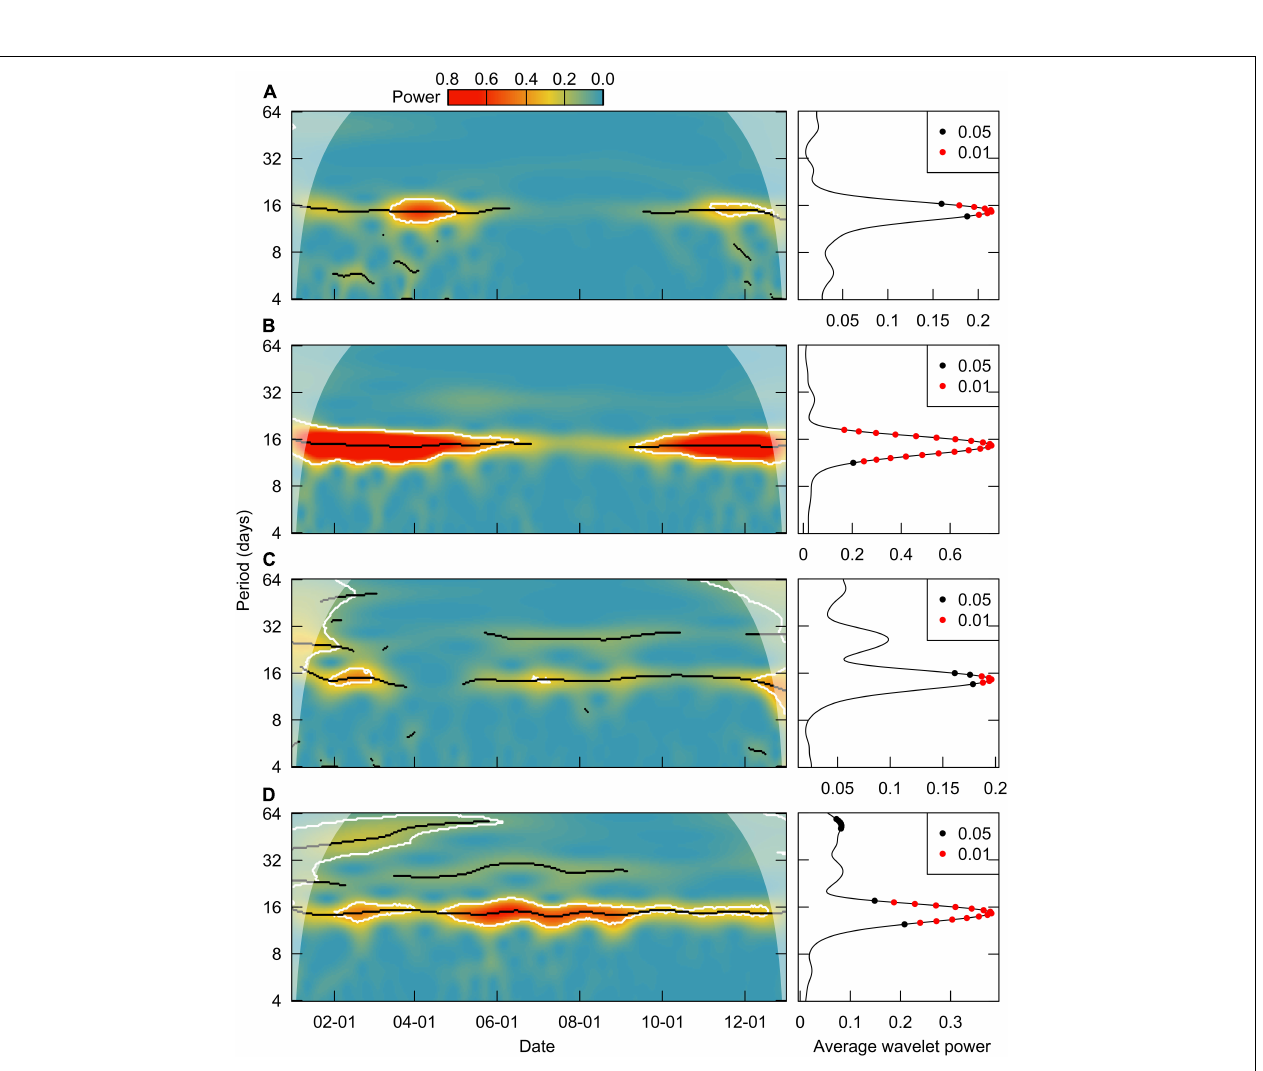
FIGURE 3 | The spatial distribution of (A) the yearly averaged wavelet power maximum over the 14–15 day period and (B) the corresponding level of significance.